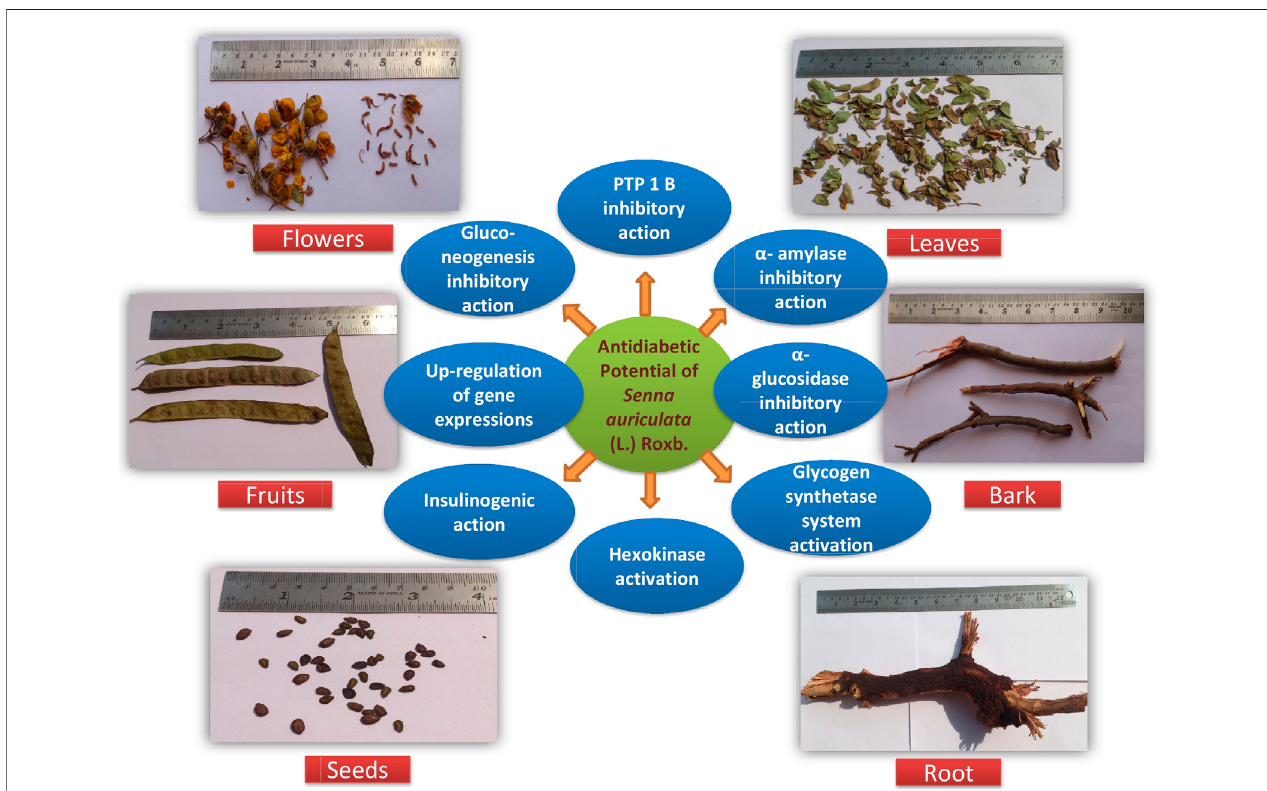
FIGURE 4 | Pictorial presentation of different plant parts of Senna auriculata (L.) Roxb. and their anti-diabetic mode of